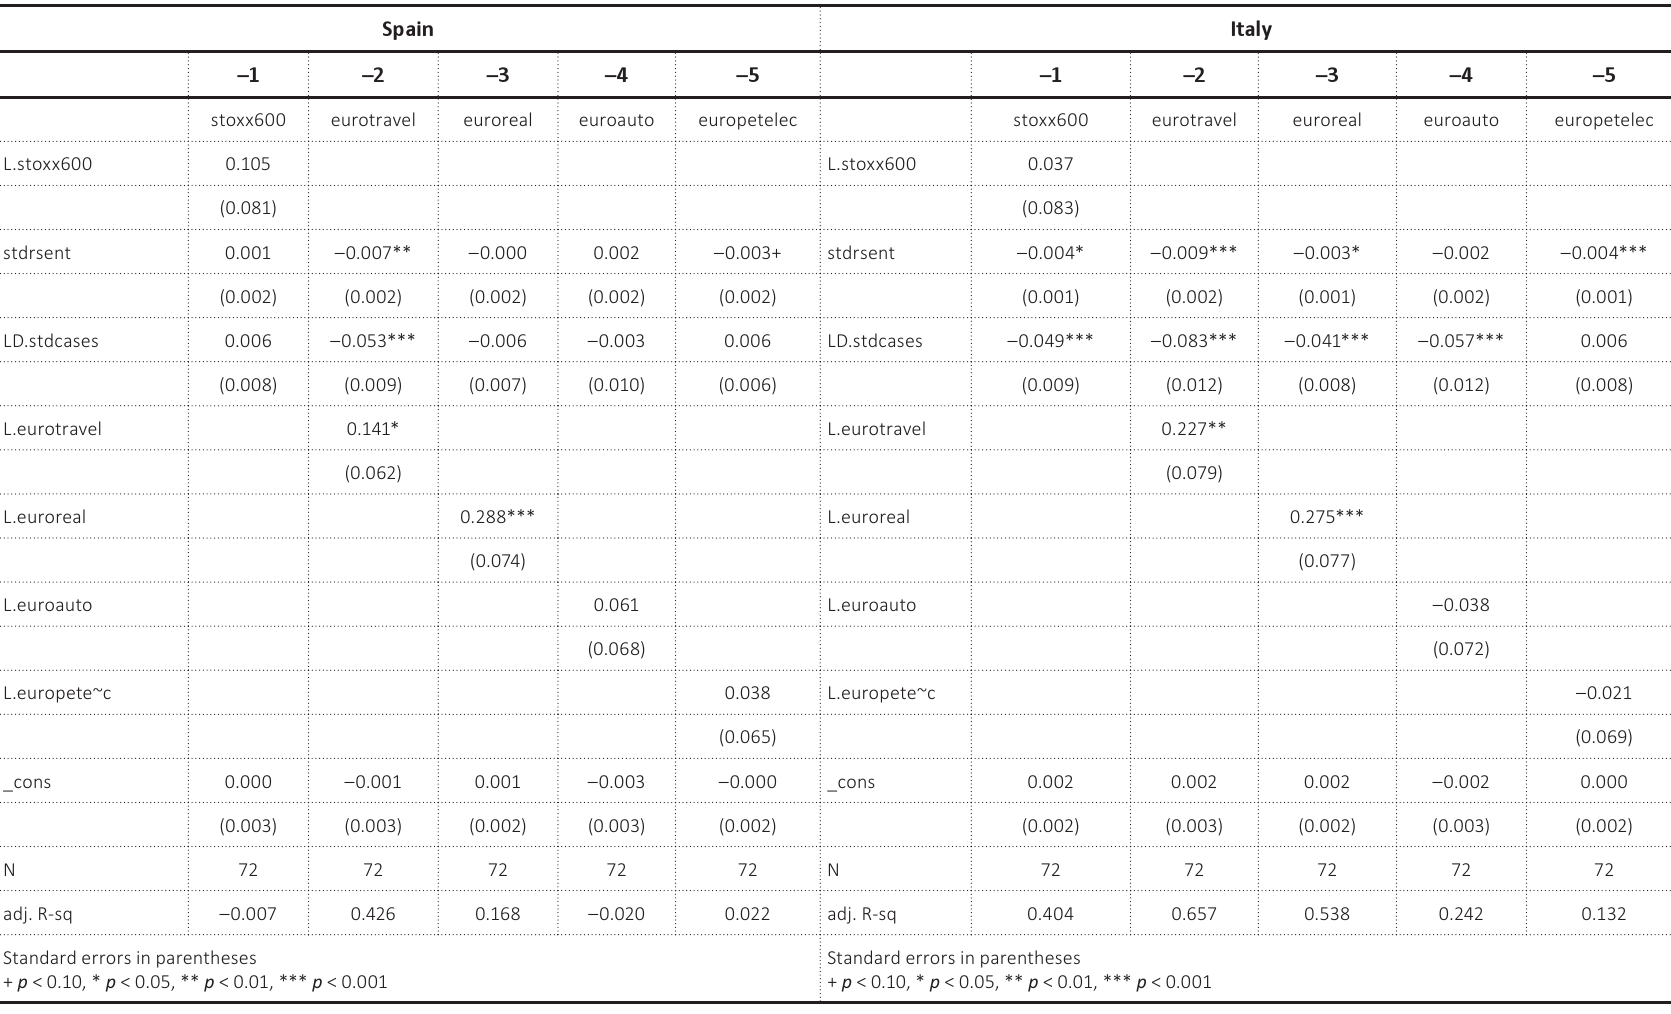
Table 4. OLS robust regressions for Spain and Italy